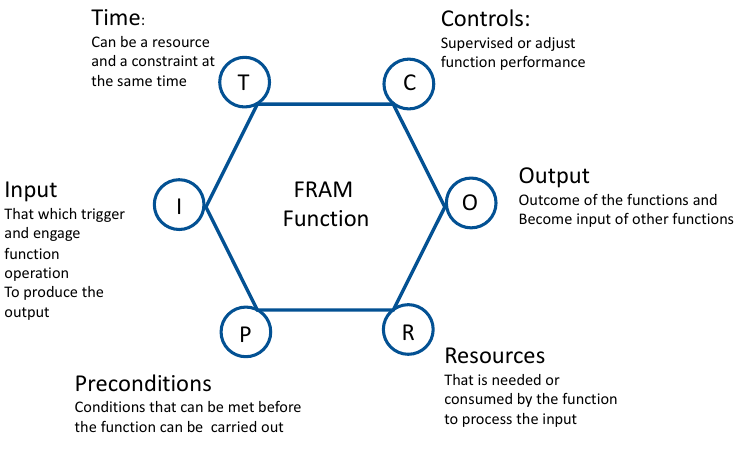
Figure 4. Functional unit of FRAM